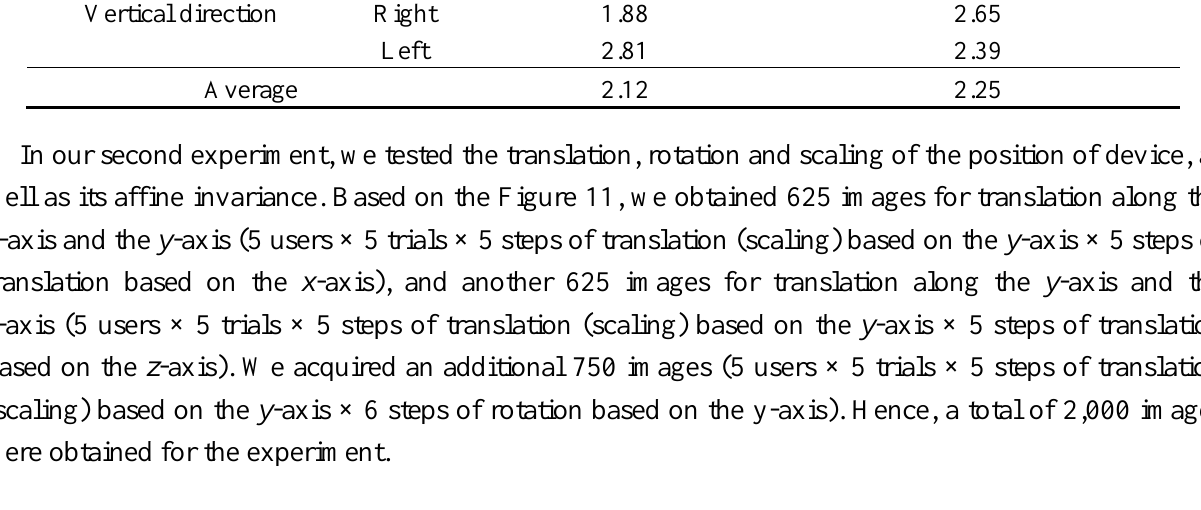
Figure 11. Axes for movement of device for